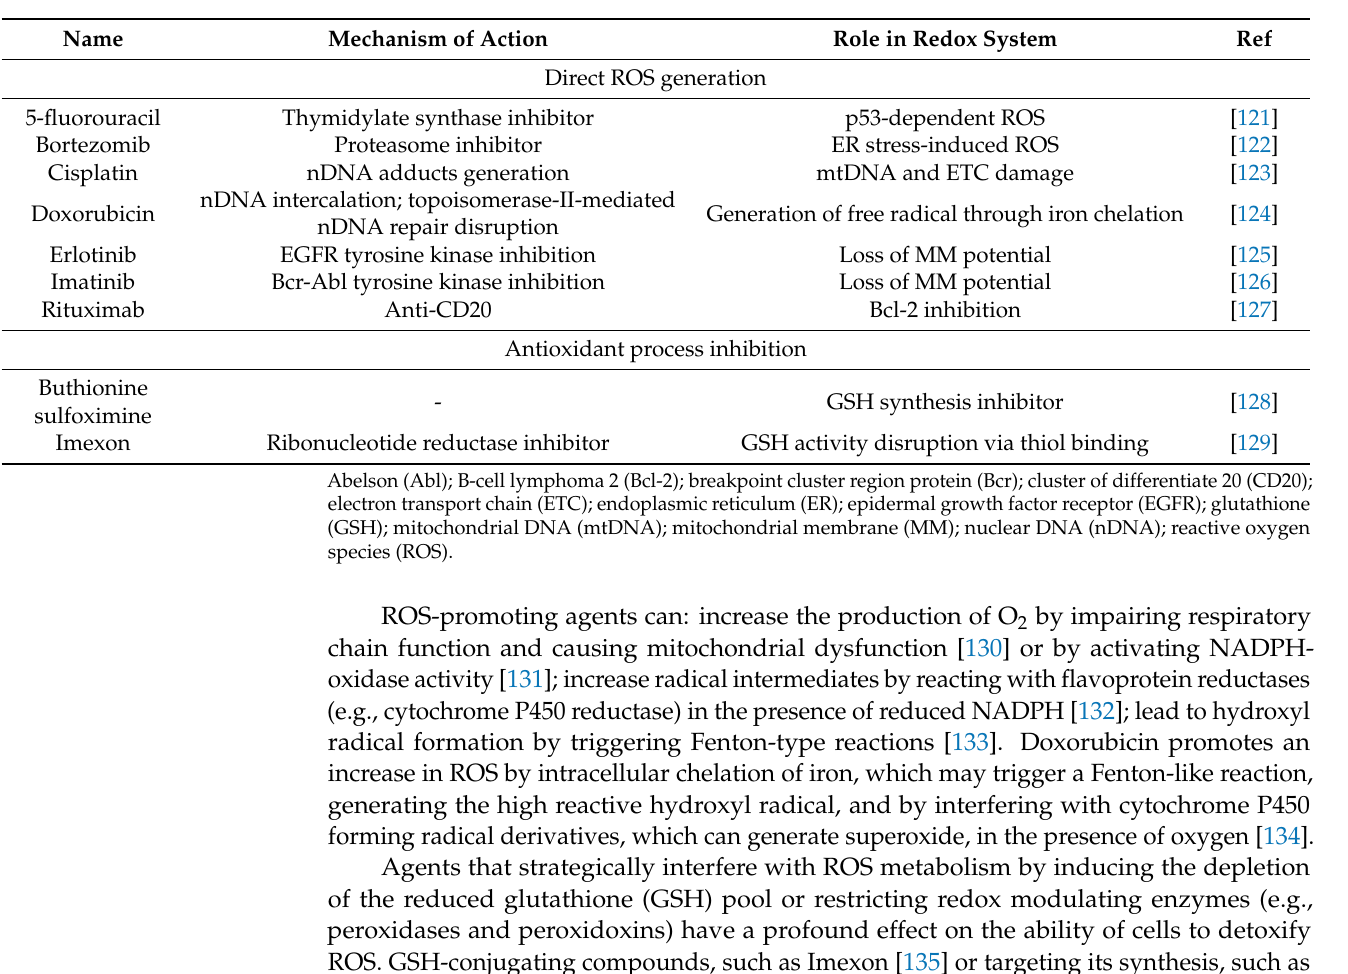
Table 1. Major anticancer compounds and respective ROS-mediated